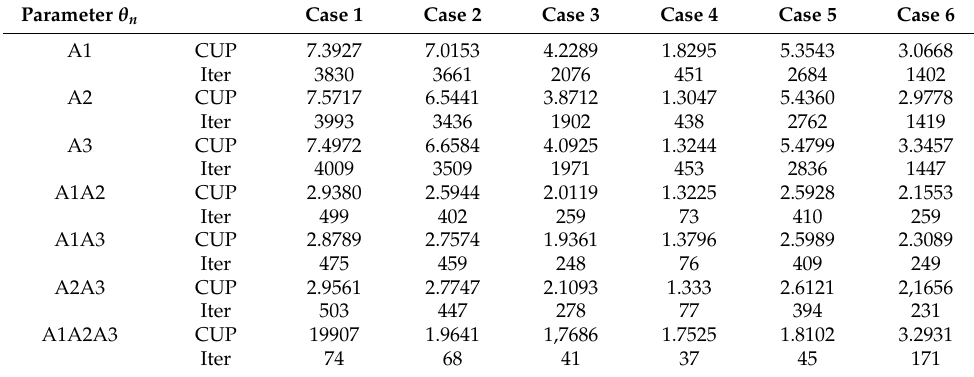
Table 6. The convergence of Algorithm 1 with each ε n for parameter θ n . Parameter θ